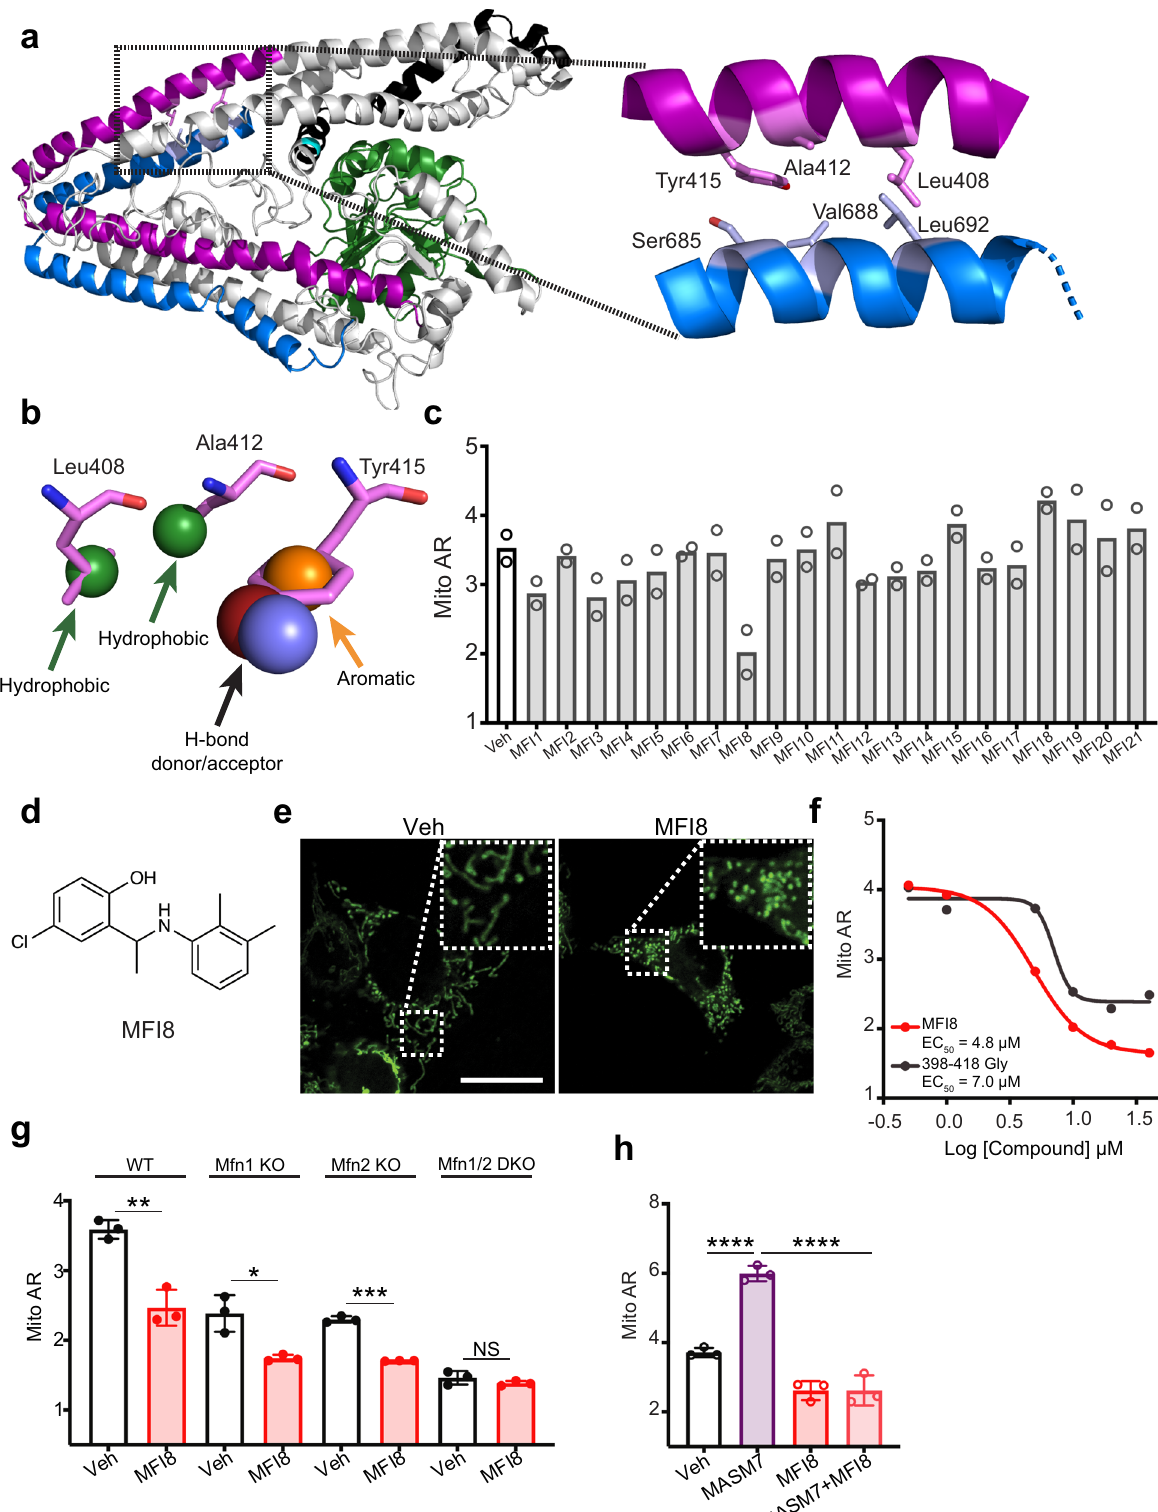
for the in silico screen (Supplementary Fig. 5b). To further validate that MFI8 meets the four criteria of the pharmacophore model hypothesis, we investigated structure activity relationships around the MFI8 scaffold. A series of MFI8 analogs were generated and evaluated for their capacity to promote mitochon- drial fragmentation in cells (Supplementary Fig. 5c,